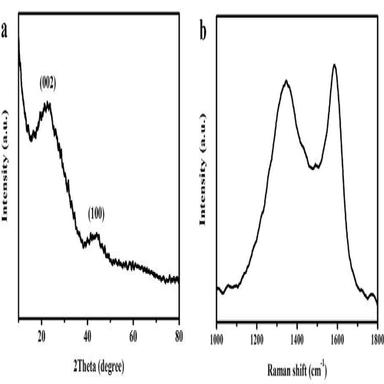
(a) XRD pattern and (b) Raman spectra of AC2.